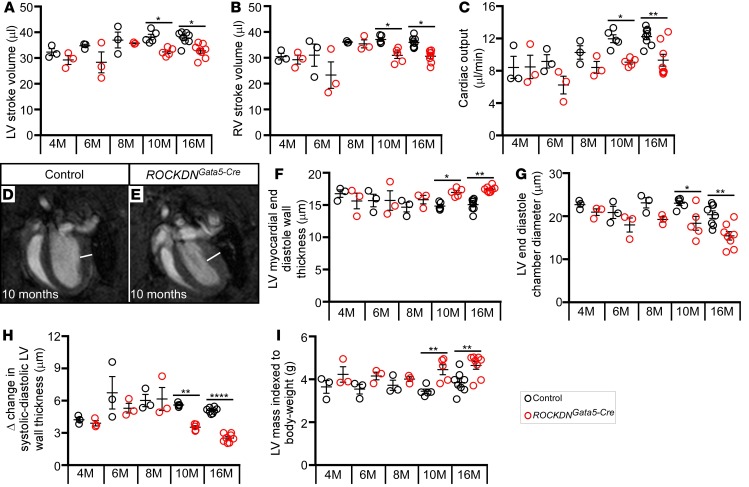
ROCKDNGata5-Cre mutants have features of hypertrophic cardiomyopathy, with increased left ventricular mass and reduced cardiac function from 10 months.Heart function was assessed by cine cardiac MRI in mice aged 4–16 months. This identified a significant reduction in left (A) and right (B) ventricle stroke volume at 10 and 16 months in ROCKDNGata5-Cre compared with control hearts, with an overall significant reduction in cardiac output also from 10 months in ROCKDNGata5-Cre mutants compared with controls (C). (D–F) In MRI images, the left ventricular wall appears thicker in ROCKDNGata5-Cre mutants compared with controls (white lines in D and E). Measurements confirmed that there was a significant increase in end-diastolic left ventricular wall thickness in ROCKDNGata5-Cre hearts (F), with a corresponding significant decrease in end-diastolic chamber diameter (G), and a significant reduction in delta change in systolic-diastolic left ventricular wall thickness (H) compared with controls, all from 10 months. There was an overall significant increase in LV mass/body weight ratio from 10 months (I) compared with controls. n = 3 for 4 months, n = 3 for 6 months, n = 3 for 8 months, n = 5 for 10 months, n = 8 for 16 months, for each genotype. Data are presented as mean ± SEM. *P < 0.05, **P < 0.01, ****P < 0.0001 by 1-way ANOVA with Bonferroni’s correction for multiple comparisons. M, month.